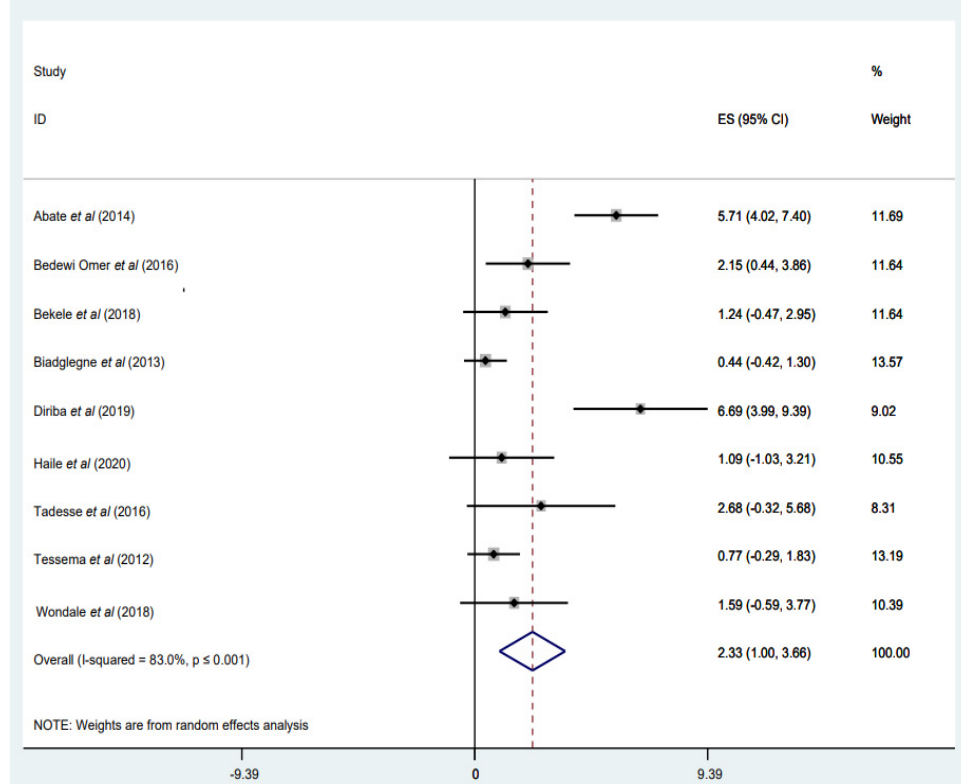
Figure 6. Forest plot showing the weighted pooled prevalence of rifampicin (RIF)-monoresistance in tuberculosis (TB) patients.